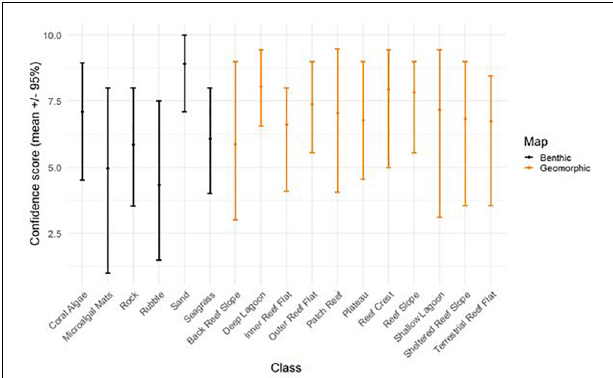
FIGURE 5 | Confidence ranking for labeling geomorphic and benthic reference data segments with a mapping class based on an average of eight experts conducting the assessment three